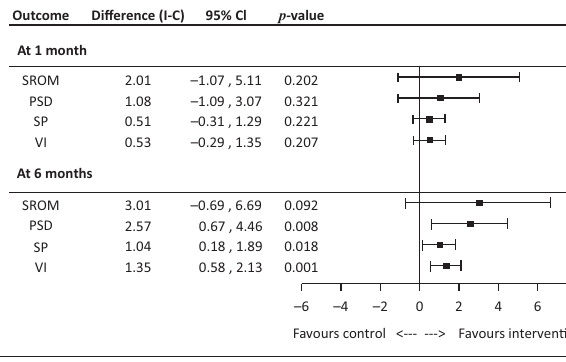
FIGURE 1: Forest plot of treatment effect at 1 and 6 months on the stuttering resource outcomes measure and its subscales positive social distance, social pressure and verbal interaction ( p =